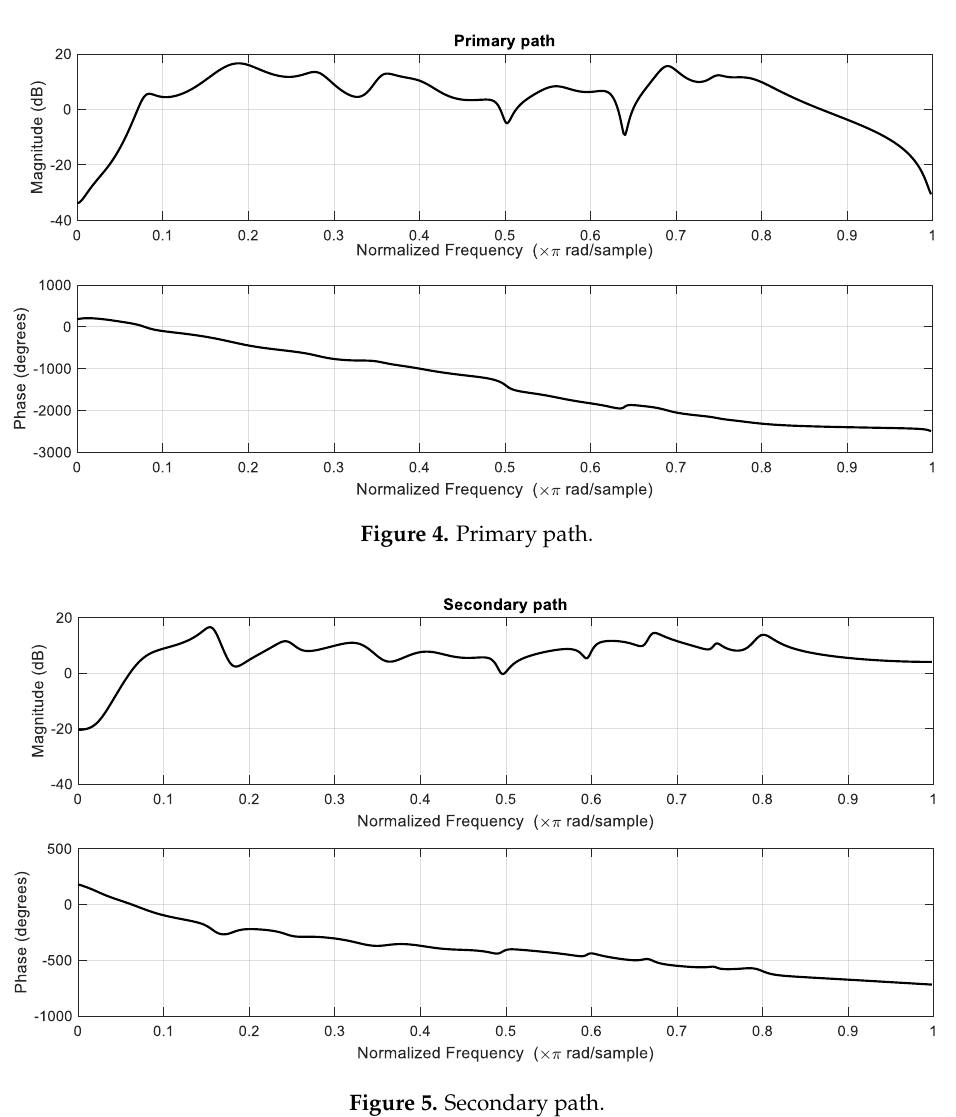
Figure 6. Theoretically predicted gain in step-size vs. simulation results of the G μ —Mod Fx H Seq LMS algorithm in a modelled ANC system.